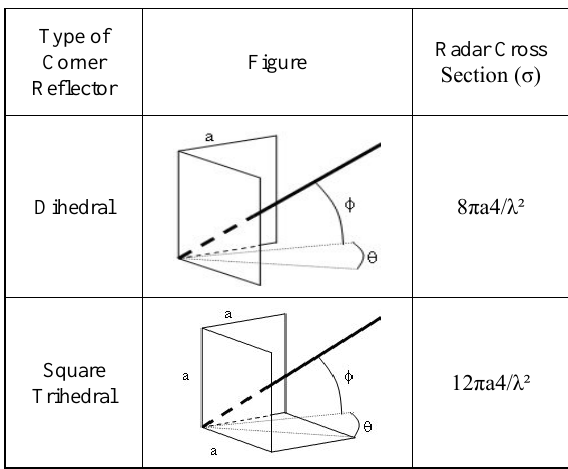
Table 1: Radar Cross Sections of different types of corner reflectors